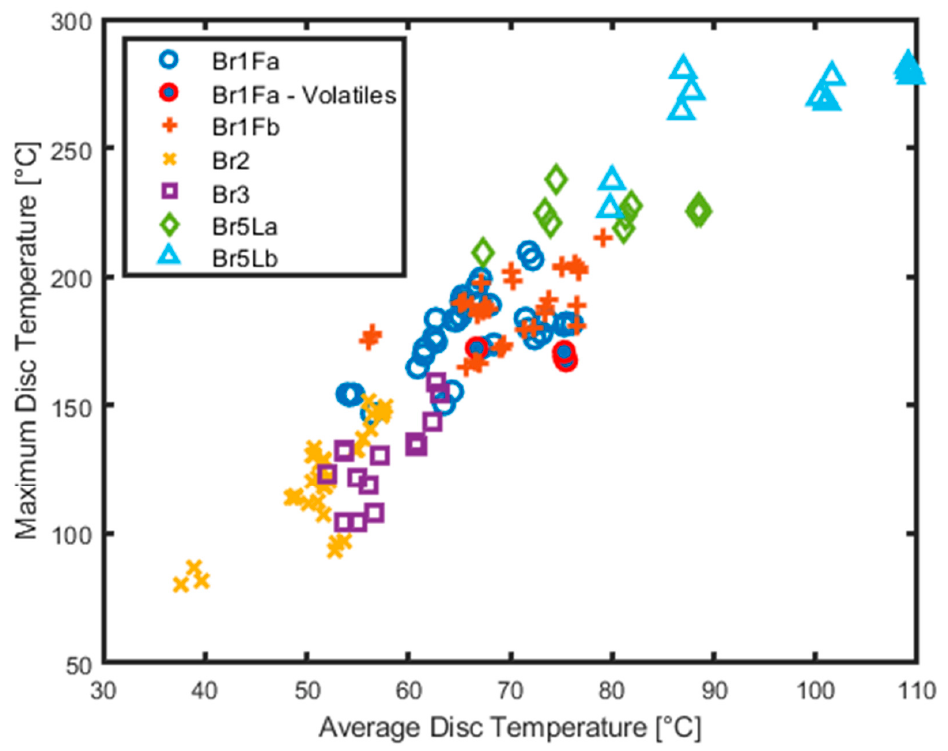
Figure 7. Overview of mean and maximum disc temperature for all emission tests. The filled circles highlight measurements with high TPN